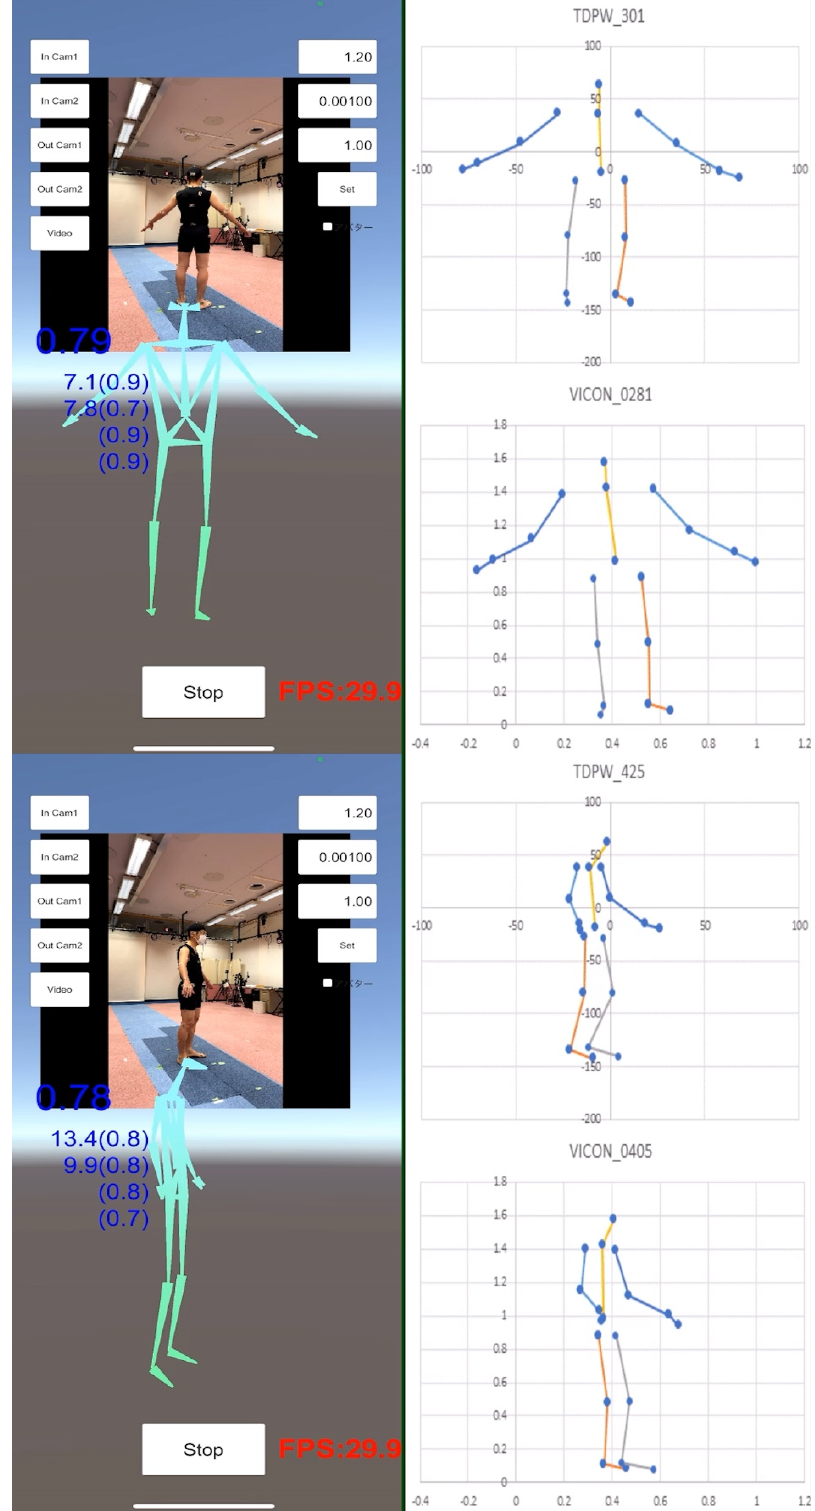
Figure 6. Simultaneous measurement by two methods of TDPT for Gait Test (TDPT-GT) application and Vicon Motion System. Blue dots indicate 3D coordinates; blue lines indicate both upper extremities, yellow indicates the trunk, gray indicates the left lower extremity, and orange indicates the right lower extremity.